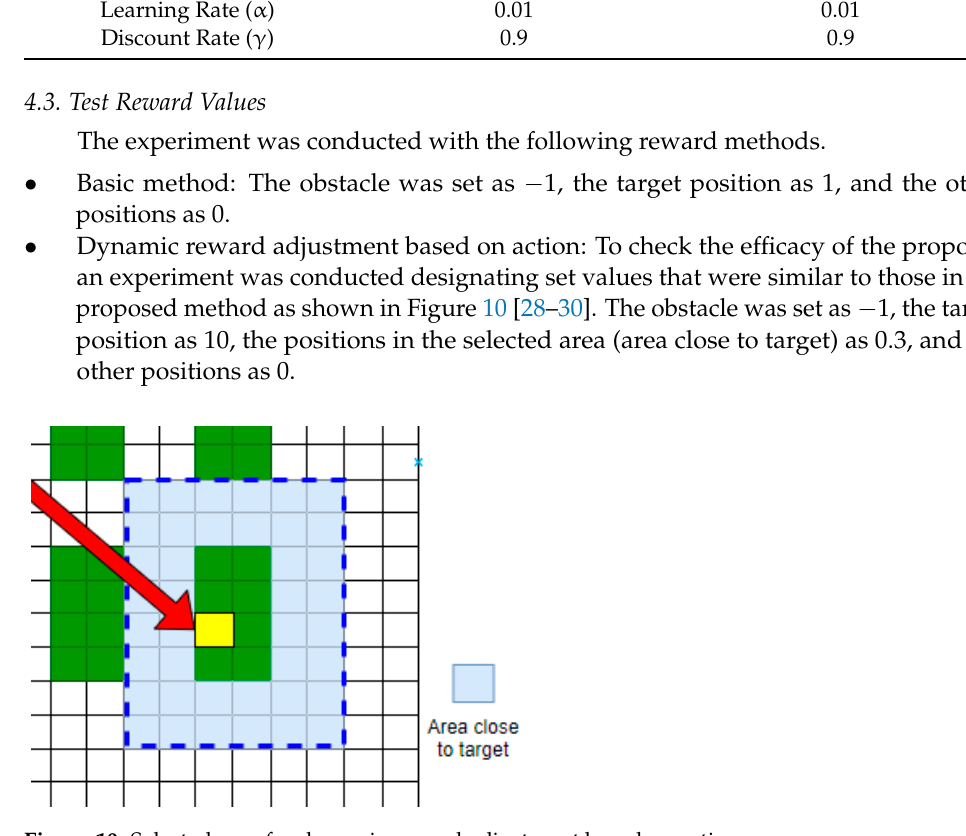
Figure 10. Selected area for dynamic reward adjustment based on action.